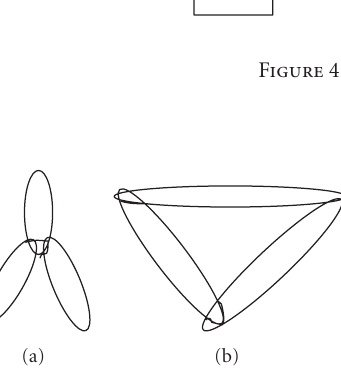
Figure 5: Representation of pairwise intersecting hyperedges with (a) nonempty and (b) empty